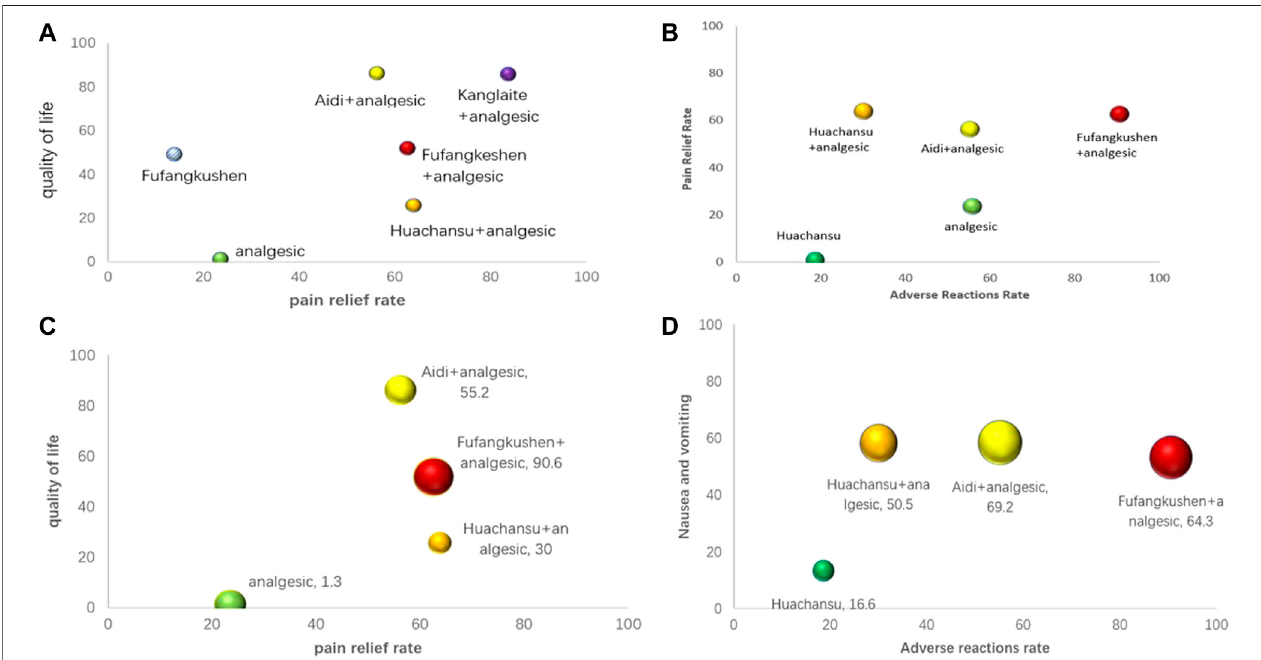
FIGURE 6 | Synthetic sorting bubble diagram plot for outcomes. (A) bubble diagram plot for pain relief rate and quality of life; (B) bubble diagram plot for pain relief rateandtotaladversereactionsrate; (C) bubblediagramplotforpainreliefrate,qualityoflifeandtotaladversereactionsrate; (D) bubblediagramplotfortheincidenceof total adverse reactions, nausea and vomiting and constipation. Note: Interventions with the same color belonged to the same regimen, and interventions located in the upper right corner indicate optimal therapy for two different outcomes. The bubble area sizes in C and D represent the third dimension ’ s outcome.